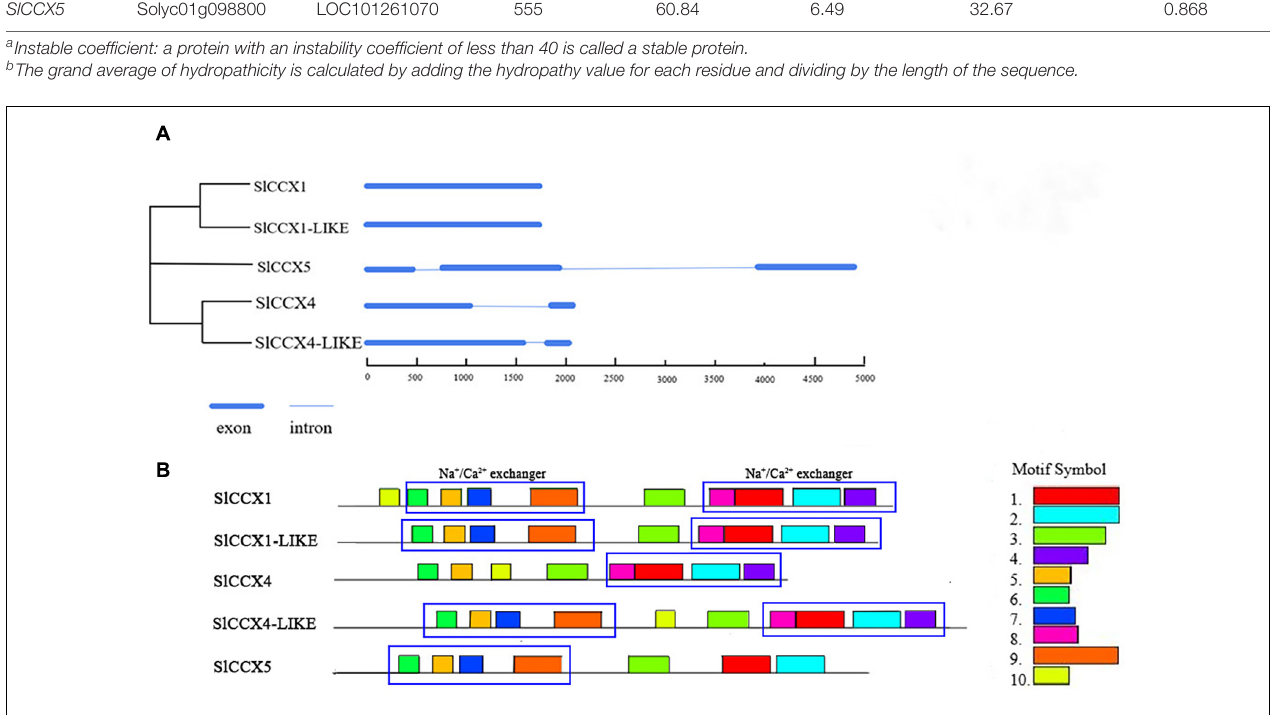
FIGURE 1 | Exon, intron, and motif analysis of SlCCXs. (A) The neighbor-joining phylogenetic analysis of the CCX subfamily in tomato. (B) Distribution of conserved motifs of CCX proteins in tomato. Different motifs are indicated by different colors numbered 1–10. The same number in different proteins refers to the same motif. The conserved Na + -Ca 2 + exchanger are shown in blue-colored